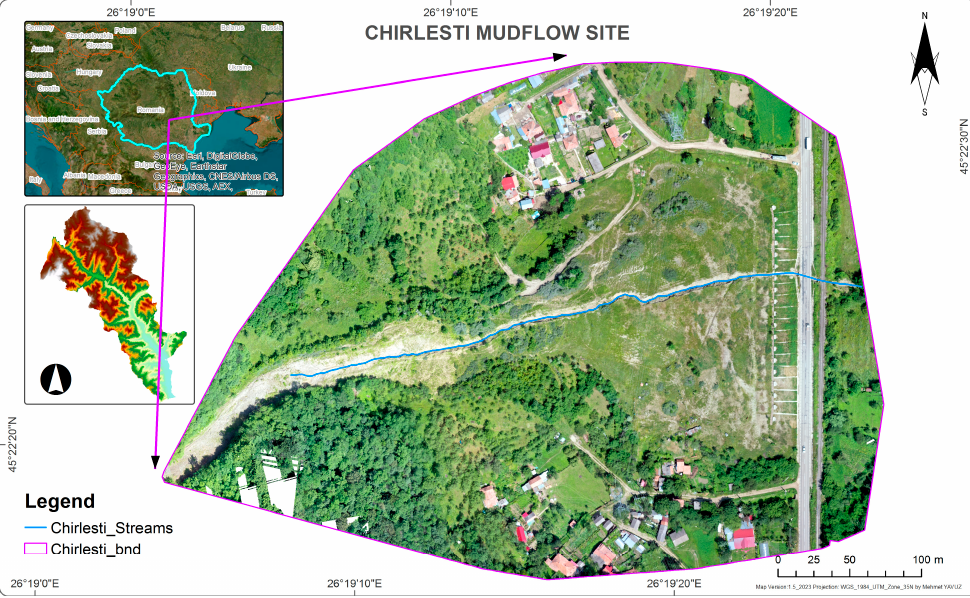
Figure 3. The Chirlesti mudflow of the Buzau River Watershed.